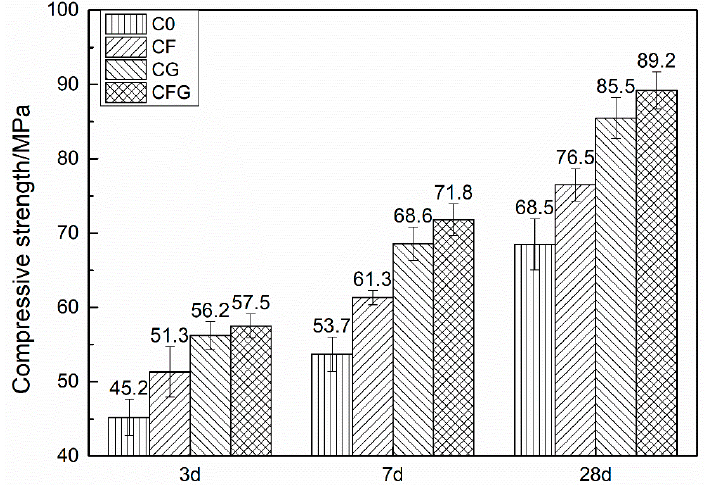
Figure 2. Compressive strength vs. curing time.